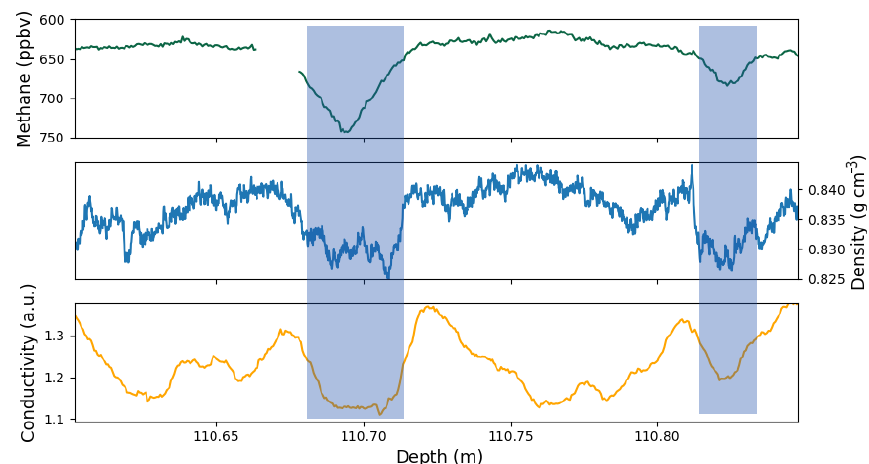
Figure 9. Examples of late closure layers highlighted by the blue shadings. The positive spikes in methane around 110 . 69 and 110 . 82m reveal the presence of open pores reaching the middle of the sample (reversed axis). These open layers are associated with low density and liquid conductivity values.